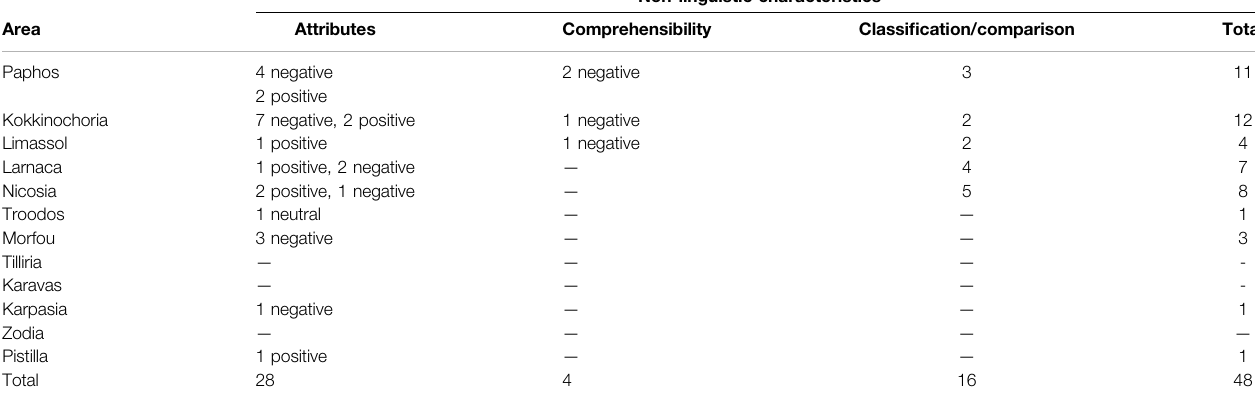
TABLE 4 | Non-linguistic